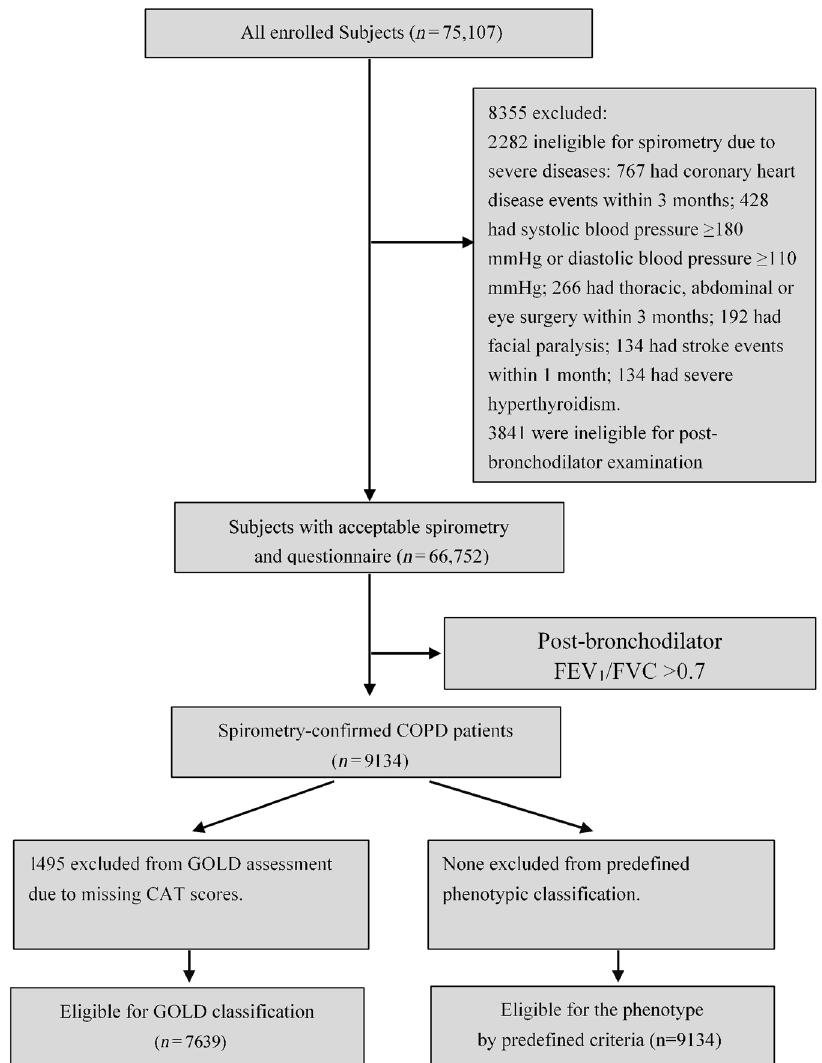
Fig. 1 Study fl ow-diagram in the study: analysis of chronic obstructive pulmonary disease phenotype. Abbreviations: COPD, chronic obstructive pulmonary disease; FEV 1 , forced expiratory volume in one second; FVC, forced vital capacity; GOLD, Global Initiative for Chronic Obstructive Lung Disease; CAT, COPD assessment